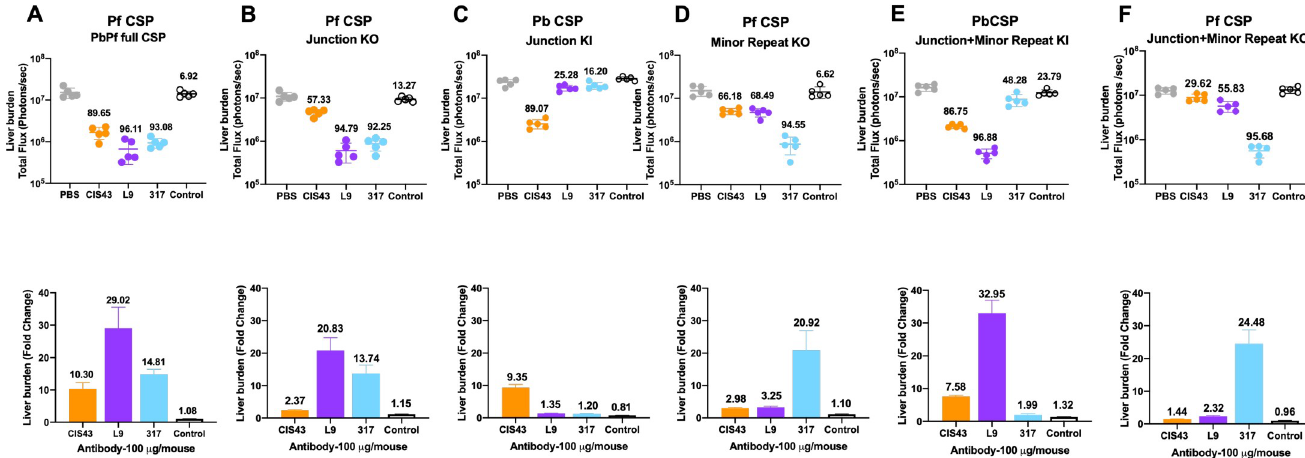
Fig 4. PfCSP mAb-mediated liver burden reduction in mice challenged i.v. with transgenic SPZ lines. C57BL/6 mice (5/group) were injected i.v. with PBS or 100 μ g of mAbs CIS43, L9, 317, or isotype control and i.v. challenged 16 hours later with 2,000 transgenic SPZ expressing A) PbPf full CSP, B) Junction KO, C) Junction KI, D) Minor Repeat KO, E) Junction+ Minor Repeat KI, and F) Junction + Minor repeat KO. Upper panels: parasite bioluminescence in the liver (total flux, photons/sec); lines indicate geometric mean and geometric standard deviation. The percent reduction, calculated in relation to the PBS control mice, is noted above each mAb group. Lower panels: fold reduction in liver burden mediated by each mAb, calculated as the ratio of the total flux in the PBS control mice divided by total flux in each mAb group.